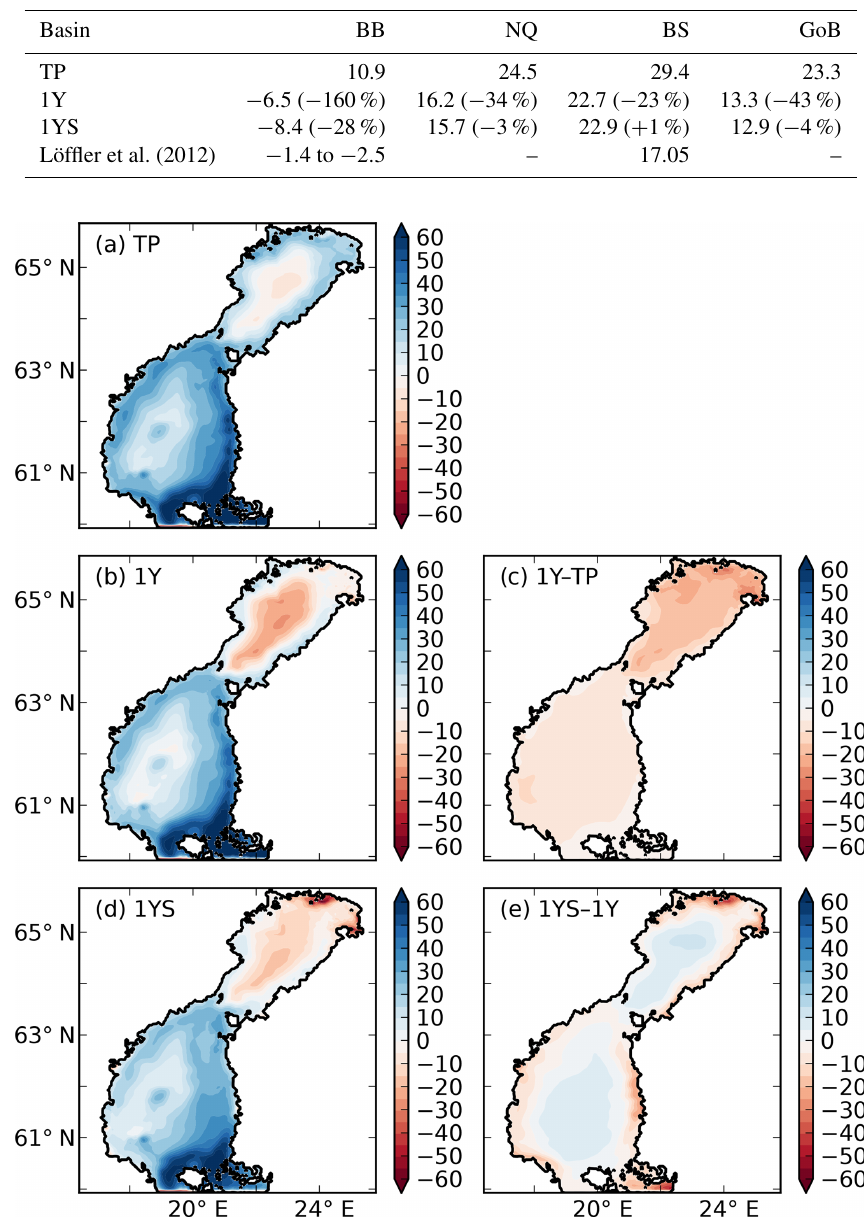
Table 4. Air–sea CO 2 exchange (1990–2010) in gCm − 2 yr − 1 in the TP, 1Y(relative change with respect to TP) and 1YS (relative change with respect to 1Y) experiments. Negative values indicate outgassing of CO 2 to the atmosphere and positive uptake of CO 2 from the atmosphere.